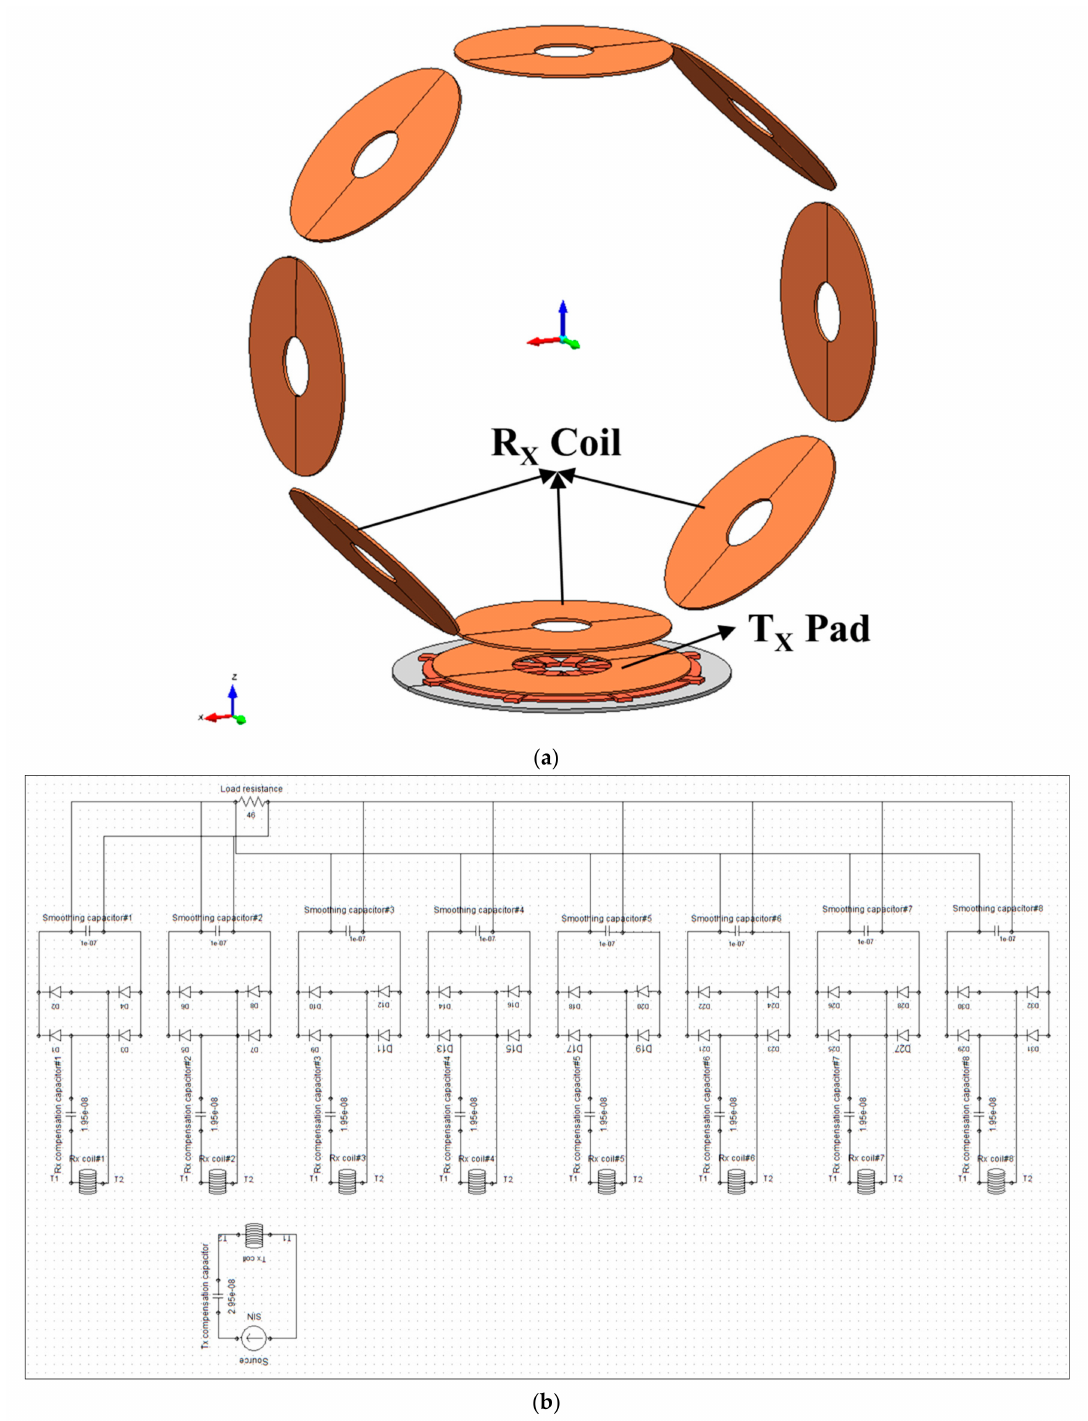
Figure 13. Simulation model: ( a ) full magnetic coupler in the wheel condition, and ( b ) circuit diagram including the compensation network and full-wave